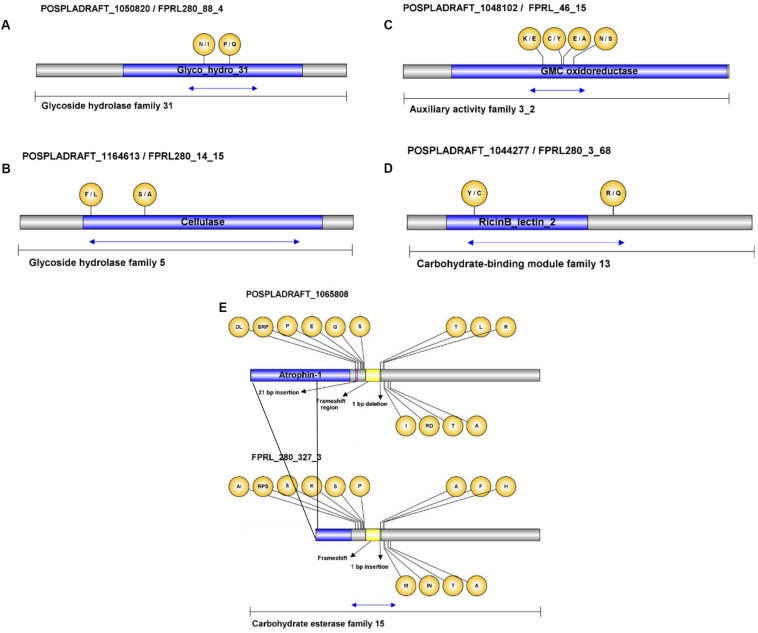
Visualization of variances and amino acid changes in selected CAZy genes. The differences were confirmed by gDNA amplification of FPRL280 followed by comparison with the published MAD-SB12 gene sequence and the FPRL280 de novo genome assembly. The amino acid changes are shown in the bubbles, MAD-SB12/FPRL280 (A–D), and as indicated (E). The blue arrows indicate the partial sequences verified by Sanger sequencing. The black lines in (E) represent the region that is missing in the FPRL280 homolog.